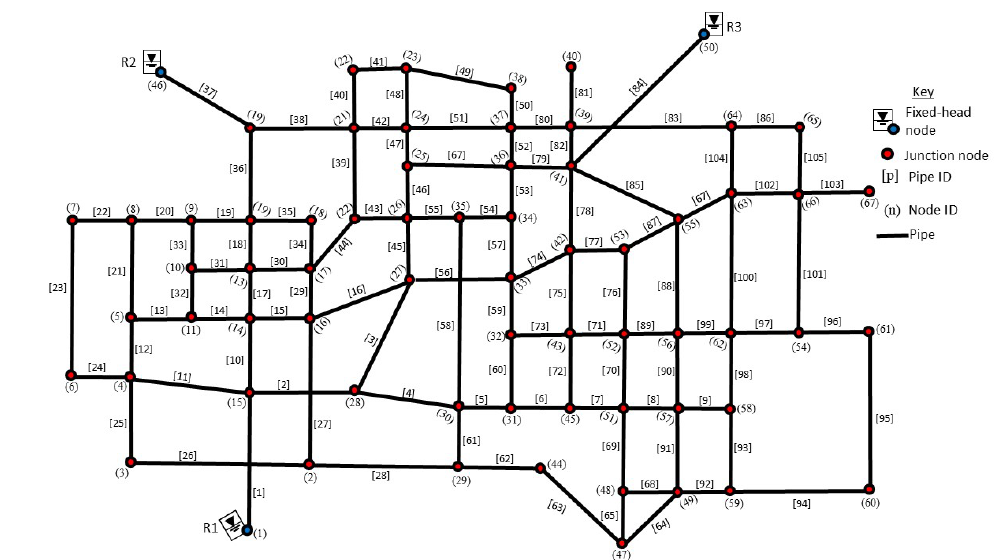
Figure 5. Schematic for Illustrative Example 3 Adedeji [47].